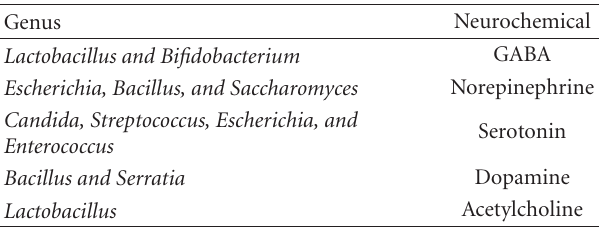
Table 2: Neurochemicals isolated from various microbes (as from